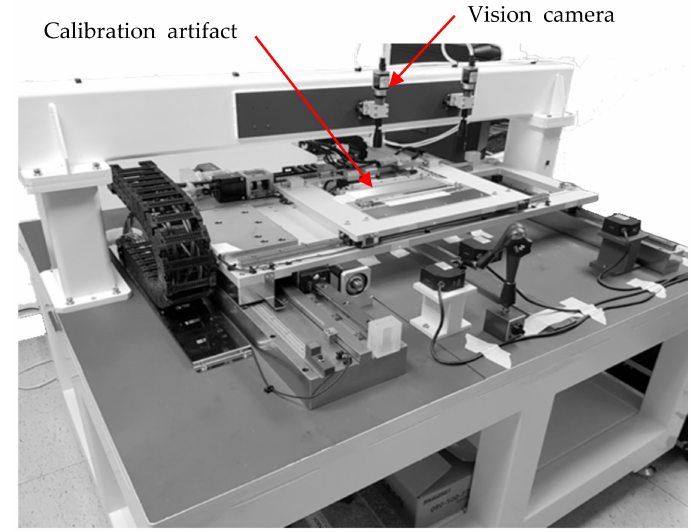
Figure 26. Test bed for improved XY linear stage.